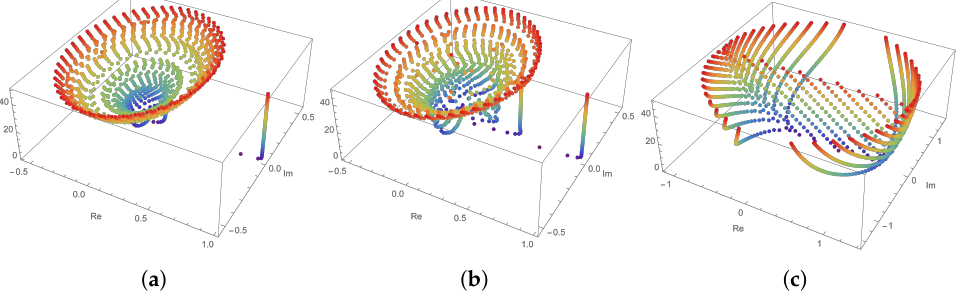
Figure 2. Structures of approximate roots of B n , q ( x ) with 0 ≤ n ≤ 50. ( a ) q = 0.2; ( b ) q = 0.5; ( c ) q =